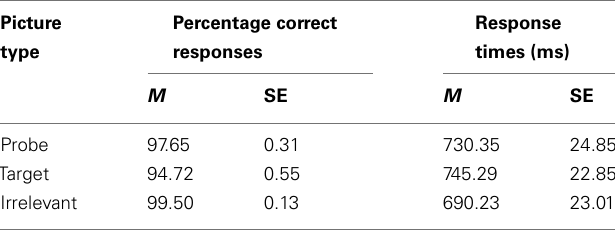
Table 1 | Descriptive statistics of the number of correct responses and mean response times depending on picture